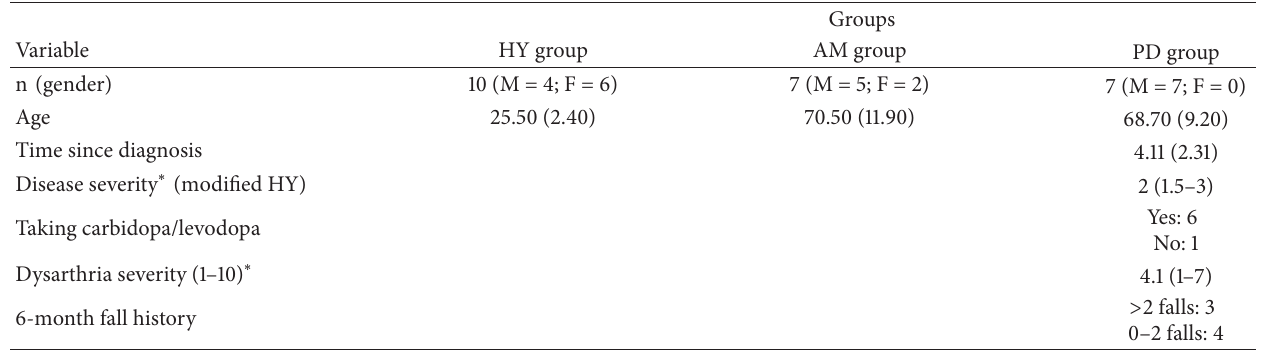
Table 1: Participant demographics.